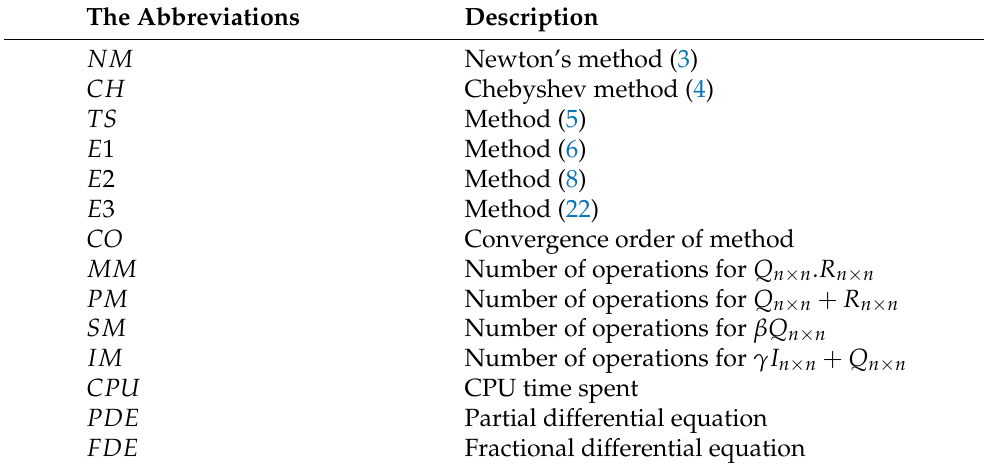
Table 1. List of abbreviations and acronyms used in the